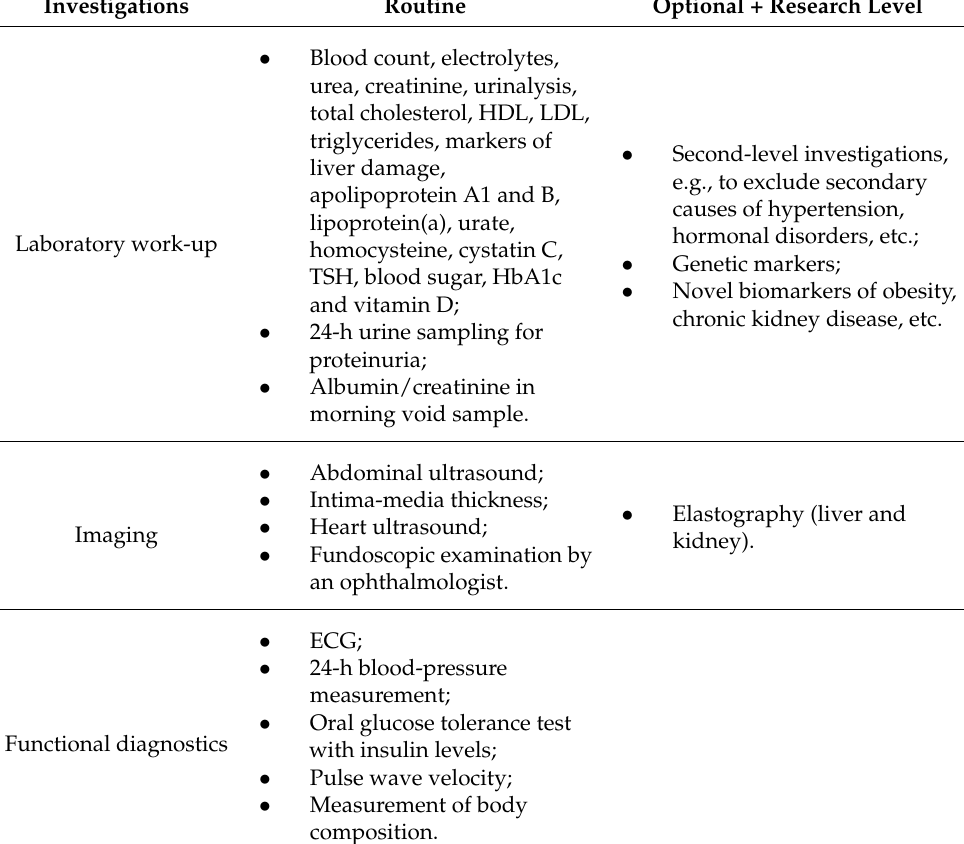
Table 1. Routine and optional investigations in children with obesity and other possible